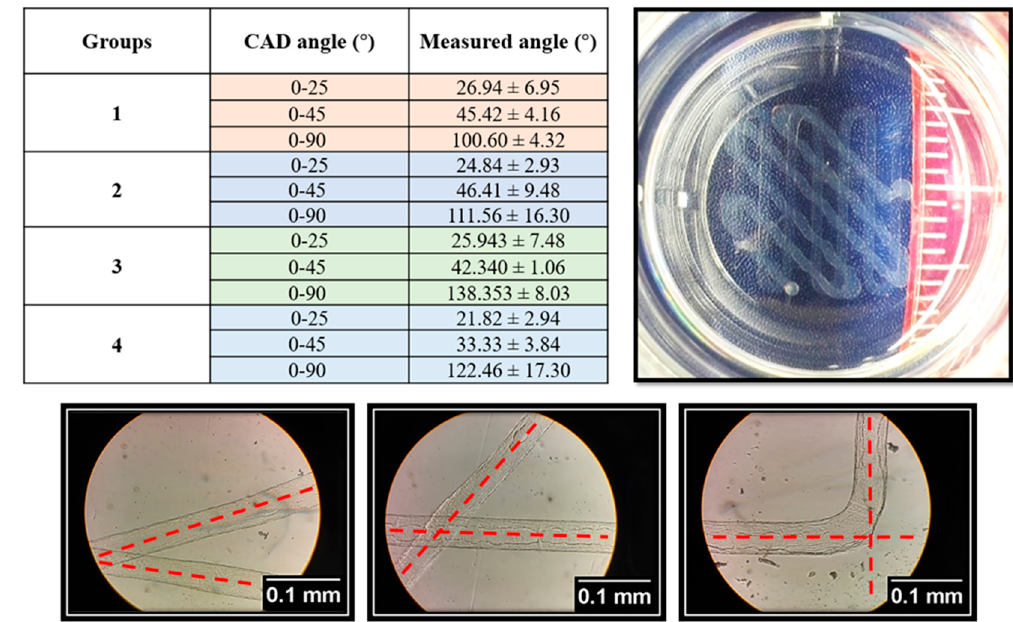
Figure 8. E ff ect of the angular pattern on the printability of sca ff olds with acute, right, and obtuse angles. Figure 8. Effect of the angular pattern on the printability of scaffolds with acute, right, and obtuse angles.